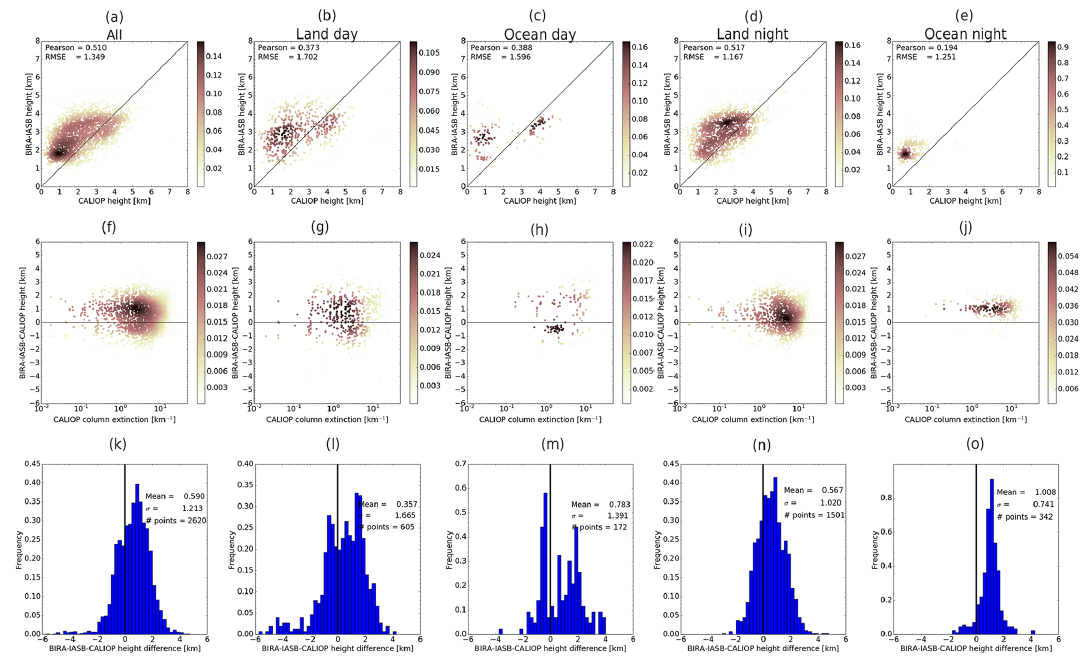
Figure A5. (a–e) Scatter plots of the CALIOP cumulative extinction height versus height from the BIRA-IASB algorithm. (f–j) Scatter plot of the difference between the BIRA-IASB and CALIOP heights versus the CALIOP column extinction. (k–o) Frequency distribution of the difference between the height from the BIRA-IASB algorithm and the CALIOP height. The mean and standard deviation of the normal distribution are given in each plot. (a, f, k) All data points. (b, g, l) CALIOP daytime data and IASI land pixels. (c, h, m) CALIOP daytime